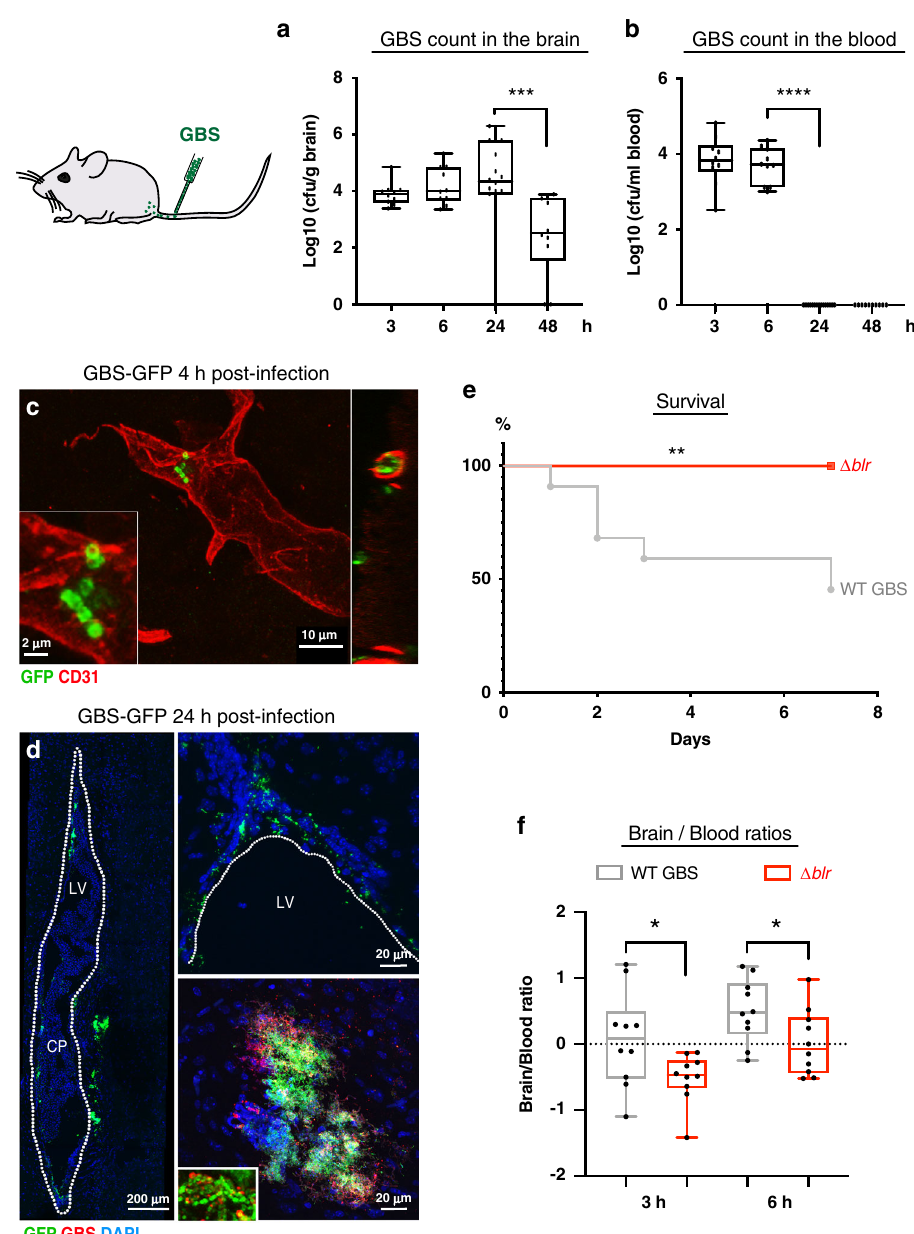
Fig. 6 Blr is a streptococcal virulence factor in mice involved in BBB crossing by GBS. a , b GBS counts in a the brain (including bacteria found in the parenchyma and inside the capillaries) [log10(cfu/g)] and b the blood [log10(cfu/ml)] of mice inoculated with WT GBS at 3 h ( n = 10), 6 h ( n = 10), 24 h ( n = 18), and 48 h ( n = 10). One-way ANOVA followed by Sidak ’ s multiple comparisons tests: p (Brain 24 h vs 48 h) = 0.0003, and Kruskal – Wallis followed by Dunn ’ s multiple comparisons test: p (Blood 6 h vs 24 h) = 8.5 * 10 − 6 . c Confocal images showing GBS-GFP (green) attached to and in the